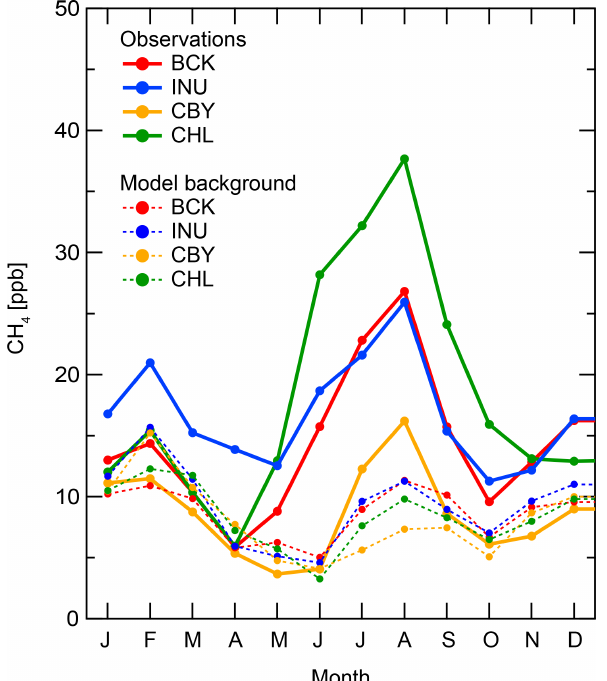
Figure 7. The 4-year (2012–2015) mean monthly SD of modelled background CH 4 mixing ratios and SD of observed CH4 mixing ratios (afternoon data only, SD_PM). The background CH 4 mixing ratios are NIES TM modelled mixing ratios weighted by the end- points of the 5-day back